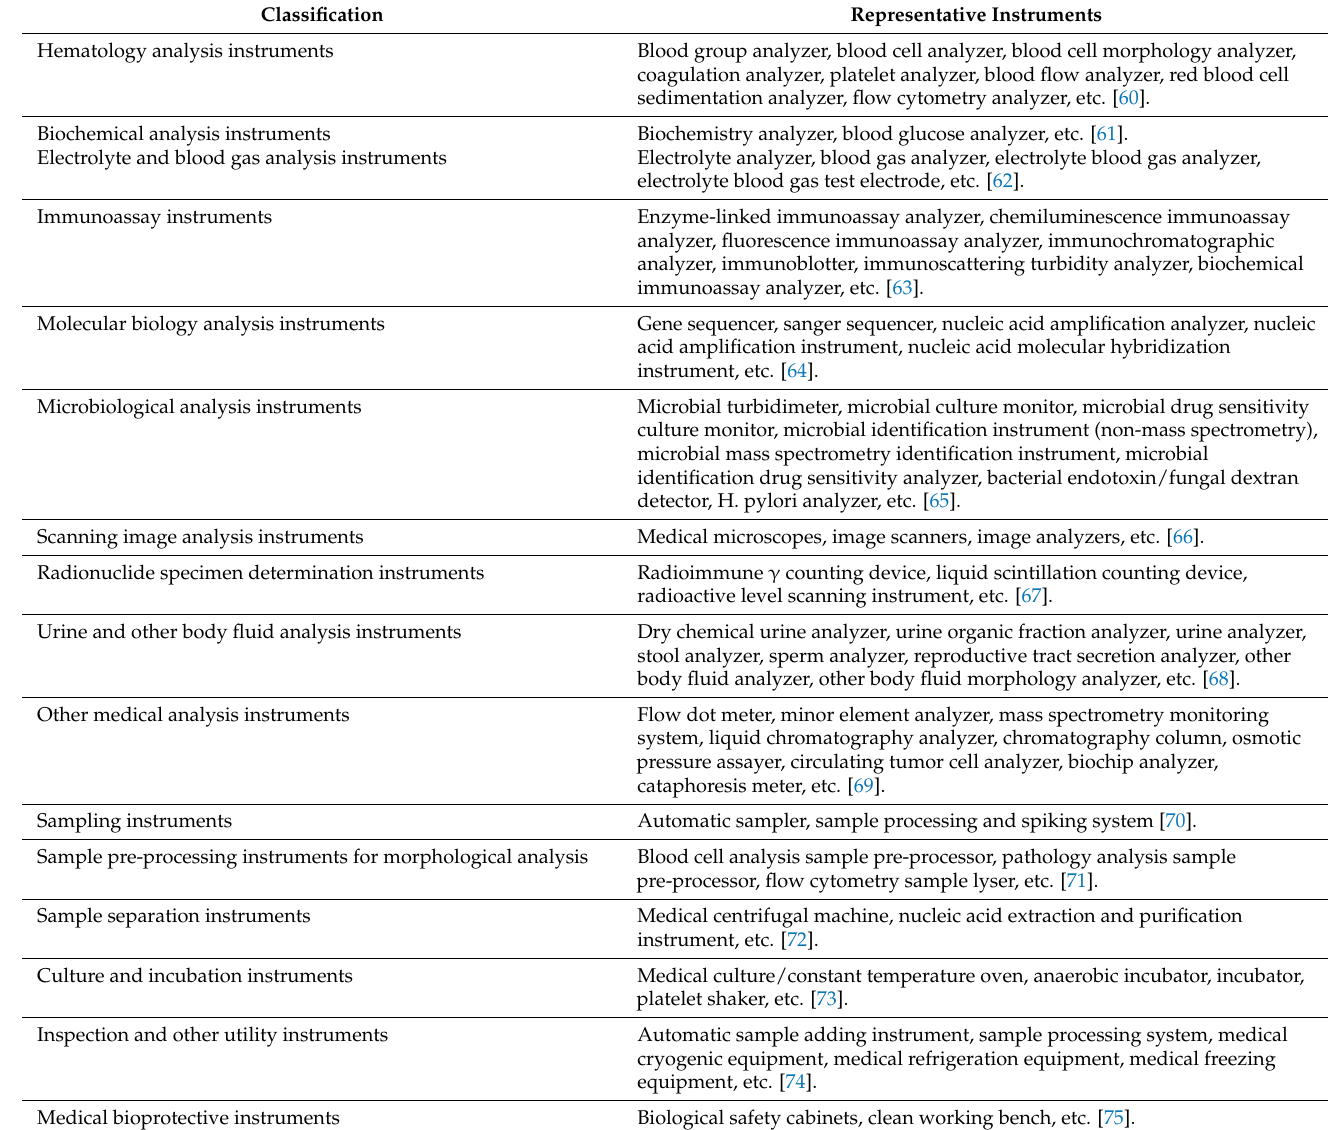
Table 2. Classification of in vitro diagnostic